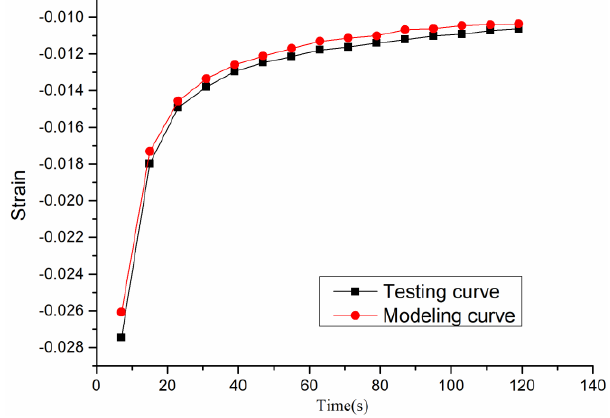
Figure 9. Testing curve and modeling curve in a Material Testing System (MTS) compaction test.